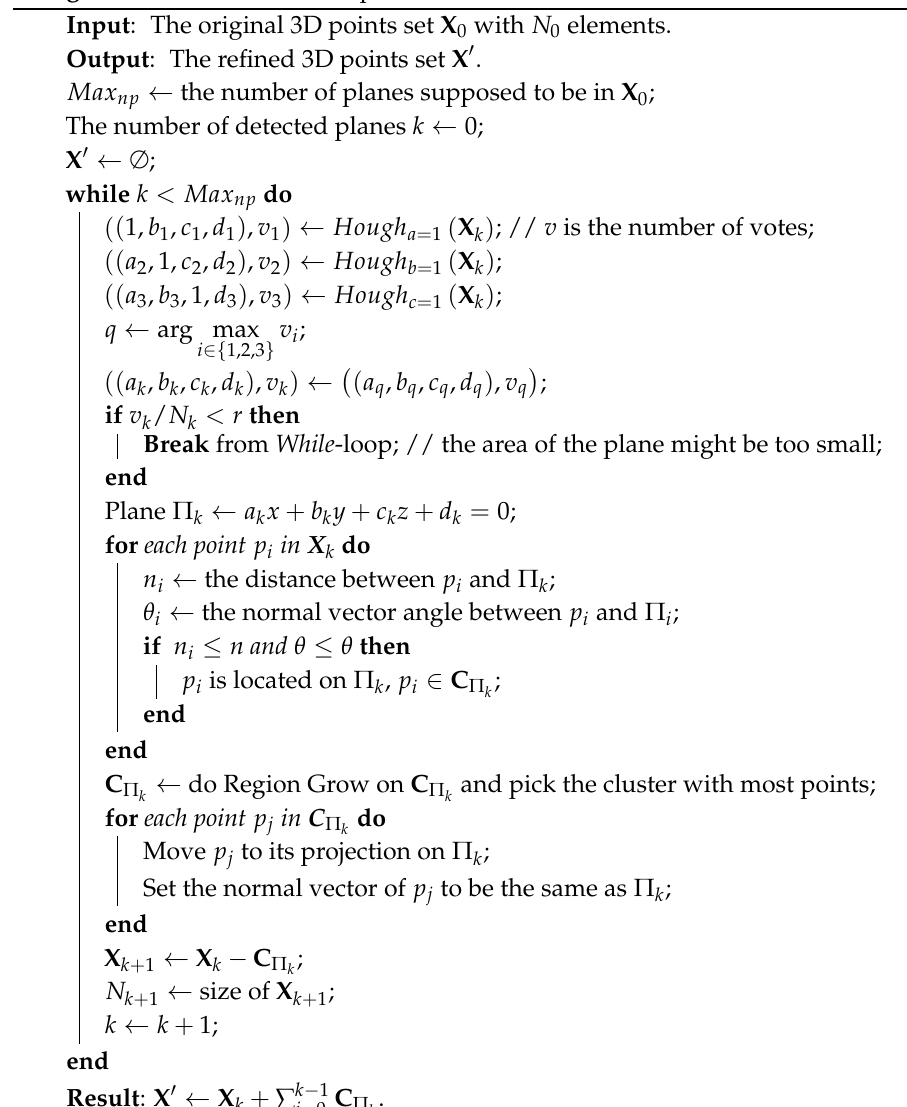
Algorithm 1: Refinement for